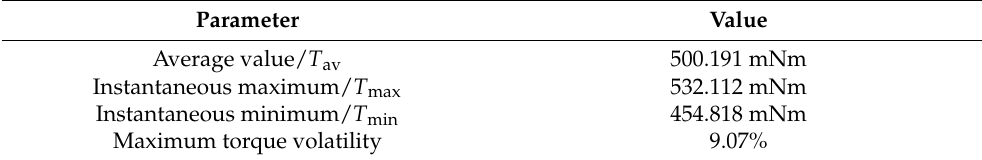
Table 3. Parameter variables to be scanned optimization variables.